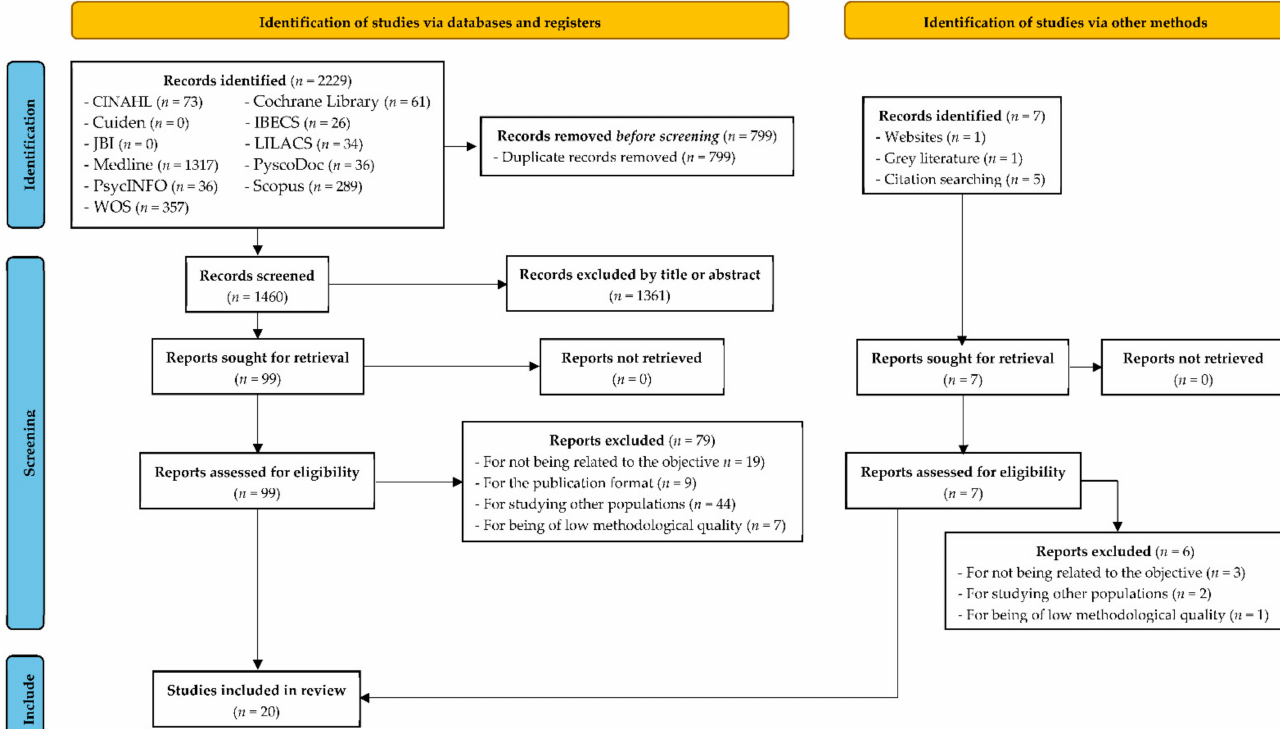
Figure 3. PRISMA 2020 flow diagram for the study selection process, which included searches of databases, registers, and other